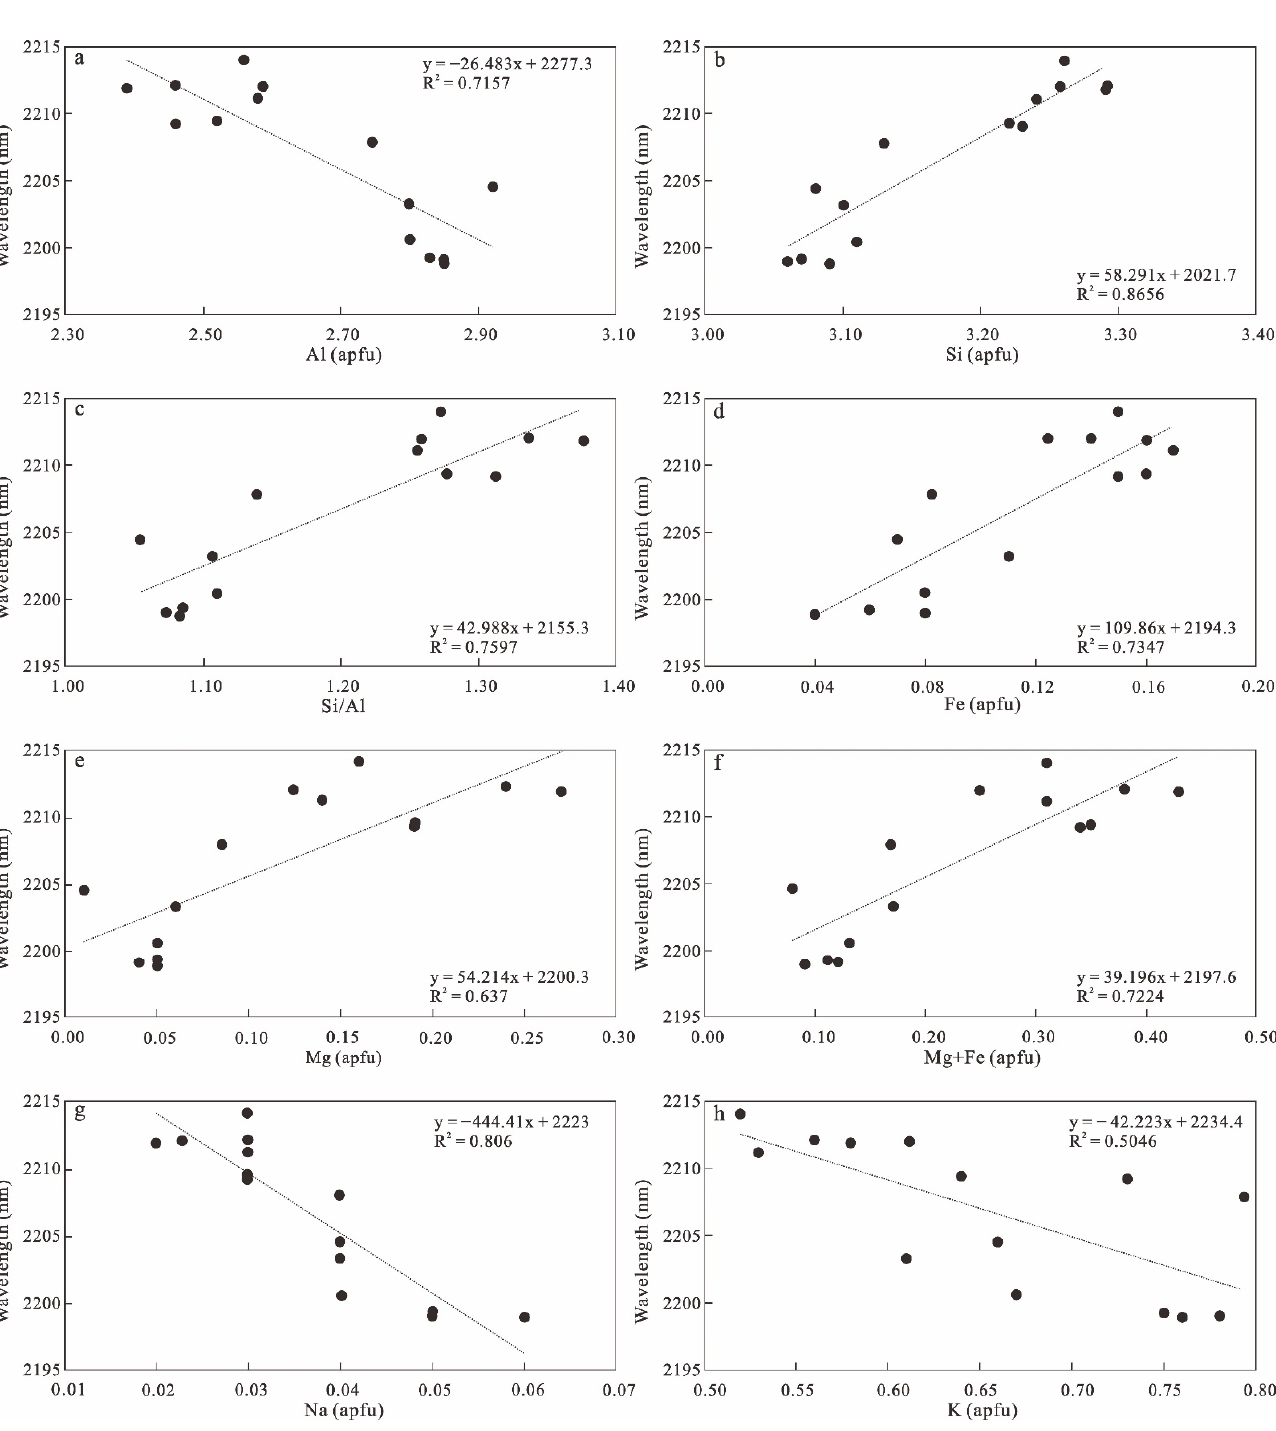
Figure 6. Binary diagram of the SWIR spectra (Pos 2200) for the Shimensi white micas vs. ( a ) Al; ( b ) Si; ( c ) Si/Al; ( d ) Fe; ( e ) Mg; ( f ) Mg + Fe; ( g ) Na; ( h ) K.